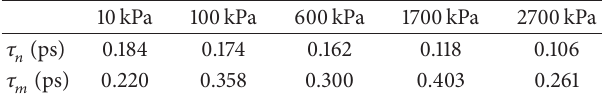
Table 2: The values of 𝜏 𝑛 and 𝜏 𝑚 for the different pressures at 77